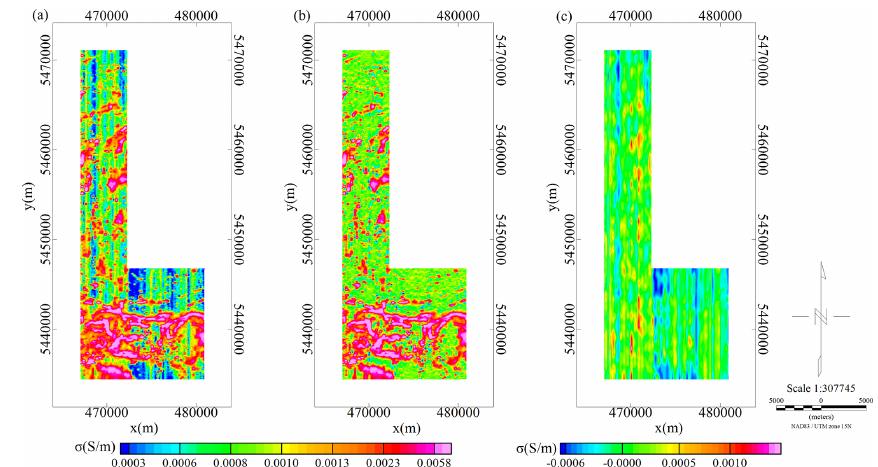
Figure 7. The leveling of the apparent-conductivity data. (a) The raw data. (b) Leveled data by the unidirectional variational model algorithm. (c) Decomposed leveling errors.